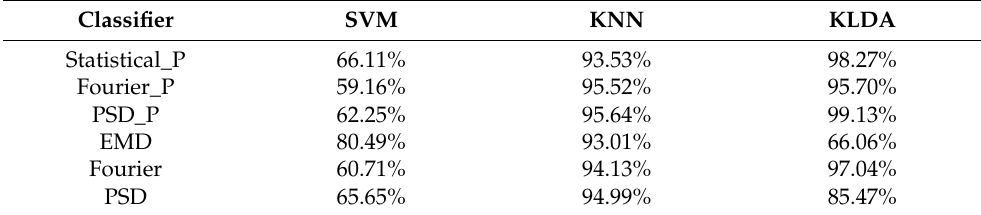
Table 1. Classification of faults.